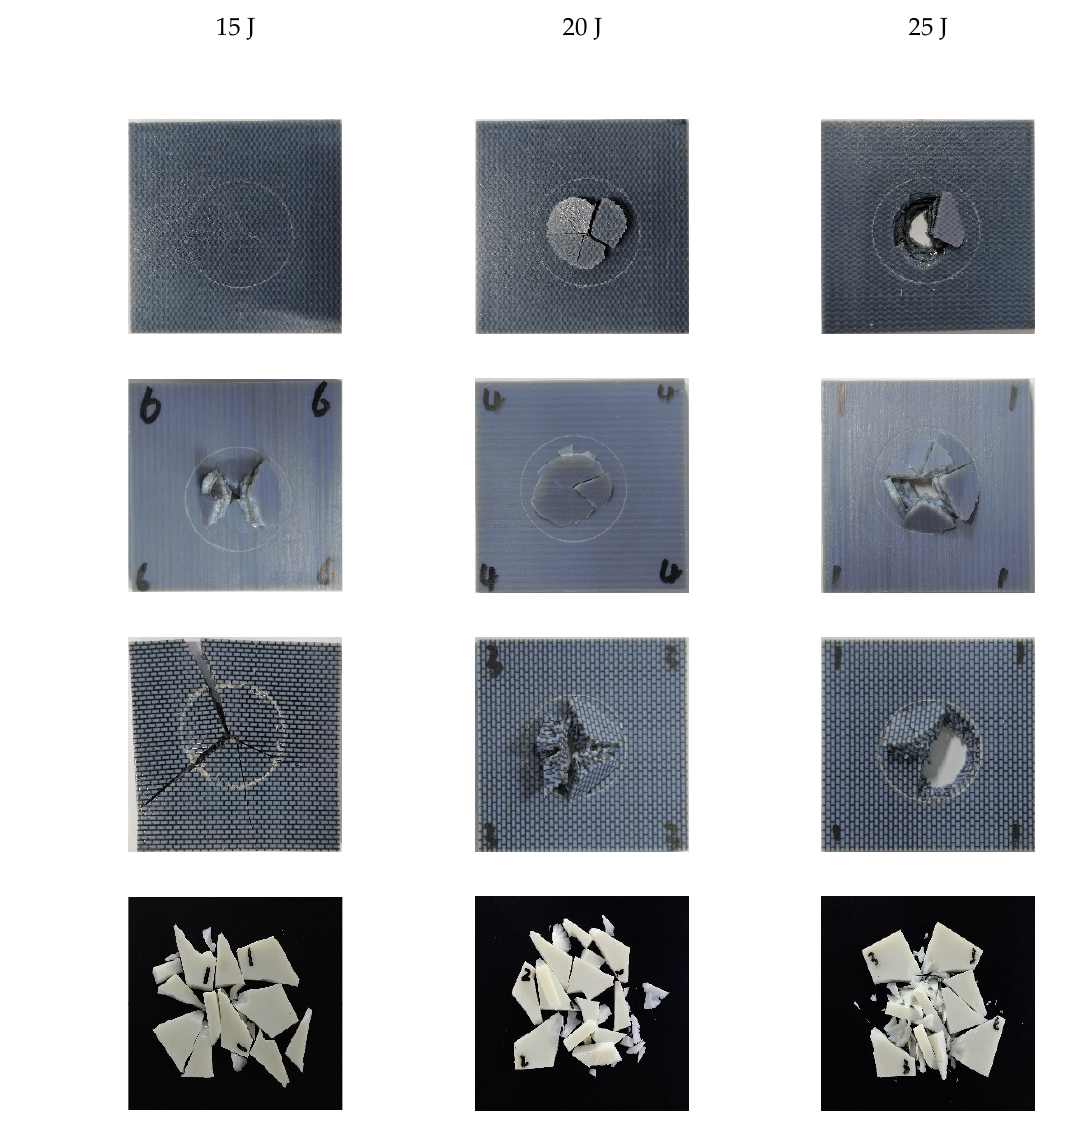
Figure 10. The damage patterns of Bio-S, Bio-B, Bio-N, and MSP. Furthermore, EA can be calculated by the integral of the force-displacement curve in Figure 8. Velocity change ∆ V was the difference between initial velocity and final velocity in Figure 9. EA, peak force, and ∆ V, as good indicators to directly compare the impact resistance, were summarized in Table 2. It can be observed from Table 2 that EA, ∆ V, and peak force of Bio-S had an obvious tendency to be higher than those of Bio-N. In terms of EA, Bio-S was 7.8% higher than Bio-N under the 25 J impact energy level. In terms of ∆ V, Bio-S was 10.2% and 13.4% higher than Bio-N under impact energy levels of 20 J and 25 J, respectively. From the above experimental results, it can be concluded that Bio-S showed the best impact resistance, Bio-N showed the second-best impact resistance, and MSP and Bio-B showed the worst impact resistance.